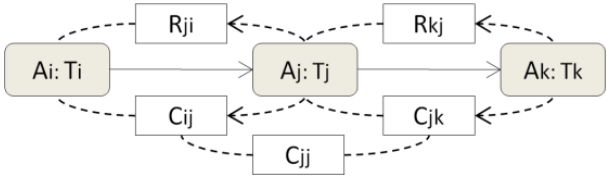
Figure 2. A semantic data processing system: Activities (A), processing targets (T), communications schemas (C), and information requirement schemas